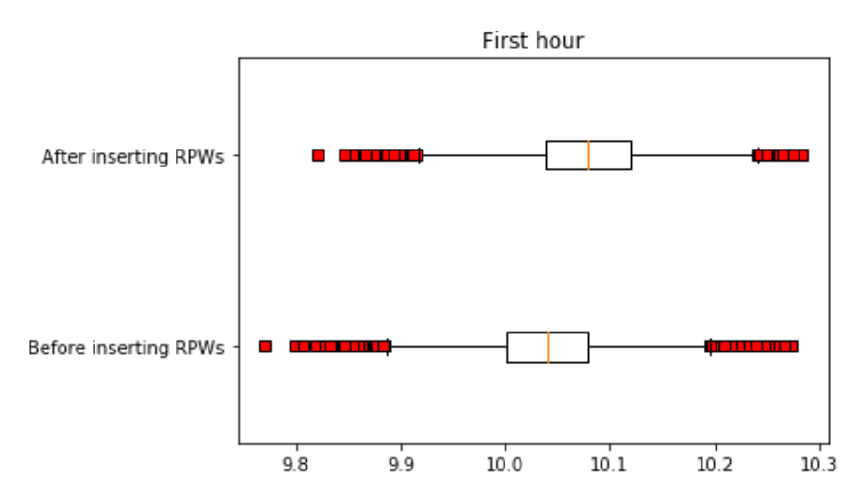
Figure 15. Box-plot graph for the outside sensor, before and after infestation for the first